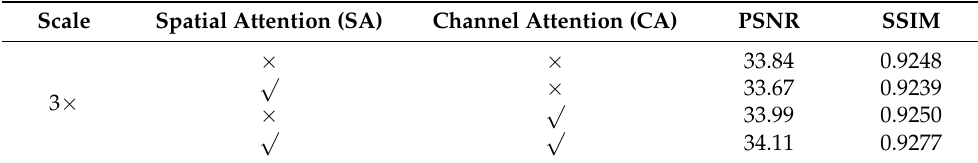
Table 2. Quantitative results of attention mechanisms. We compared four different models (whether they contain spatial attention or channel attention) on the Set5 dataset for 3 × SR. The model that includes both channel and spatial attention achieves superior performance.